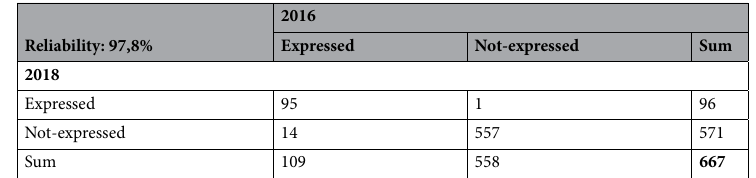
Table 2. Reflects the fourfold characterization of mean differential expressed and non-expressed miRNAs compared to SHAM from all donors in 2016 and 2018. The analysis revealed a high degree of consistency concerning the expression behavior up to 97.8% by comparing both years. The total number (667) of all miRNAs examined in 2016 and 2018 is shown in